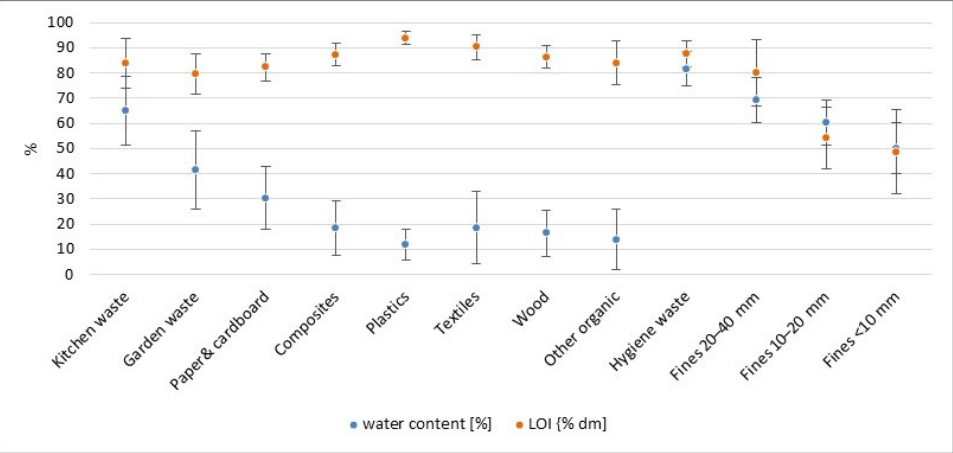
Figure 13. Water content and loss of ignition (LOI) of the residual waste fractions.